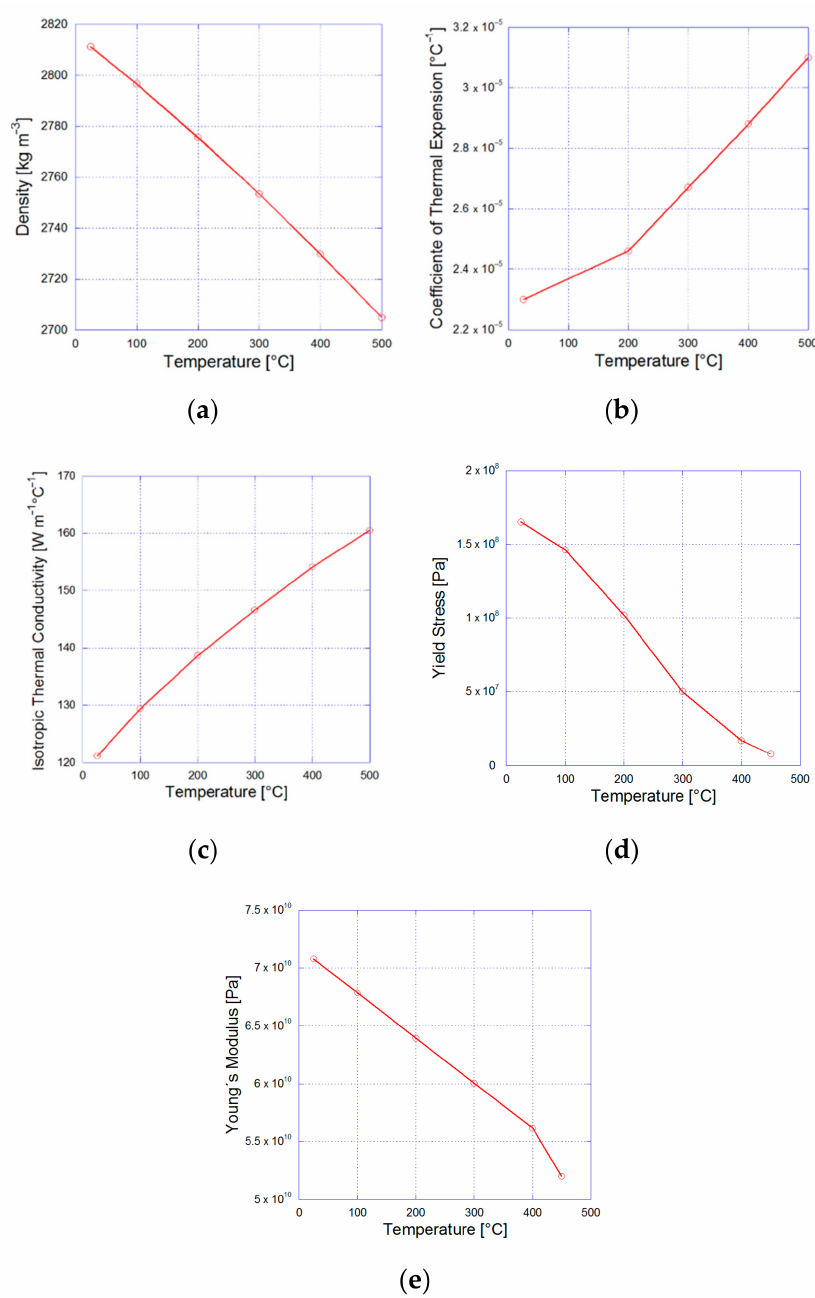
Figure 3. Variations are considered for every temperature modification with respect to ( a ) the density, ( b ) the coefficient of thermal expansion, ( c ) the isotropic thermal conductivity, ( d ) the yield stress, and ( e ) Young’s